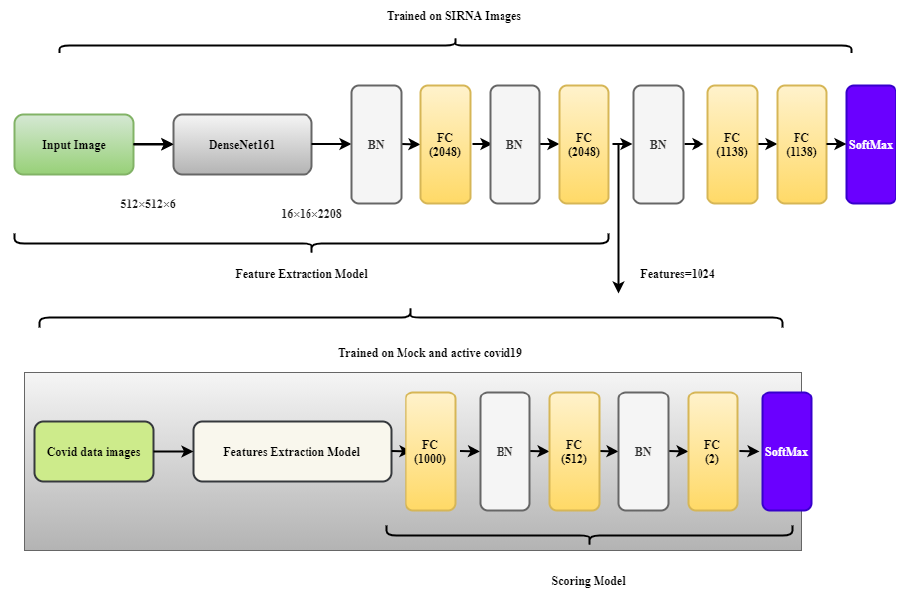
Figure 4. Architecture of the COVID-19 drug development